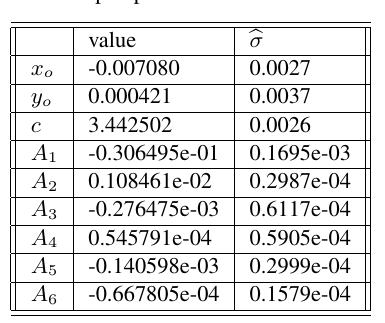
Figure 4: Typical image of the testfield with detected coded tar- gets of the known 3d-passpoints.